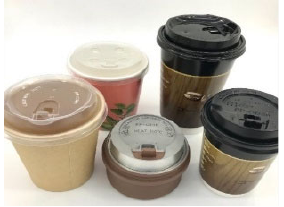
Figure 1. Polypropylene coffee lid with molds. Table 1. Properties of raw materials for producing polypropylene coffee cup lids. Selection of Reference Values for Raw Material Properties